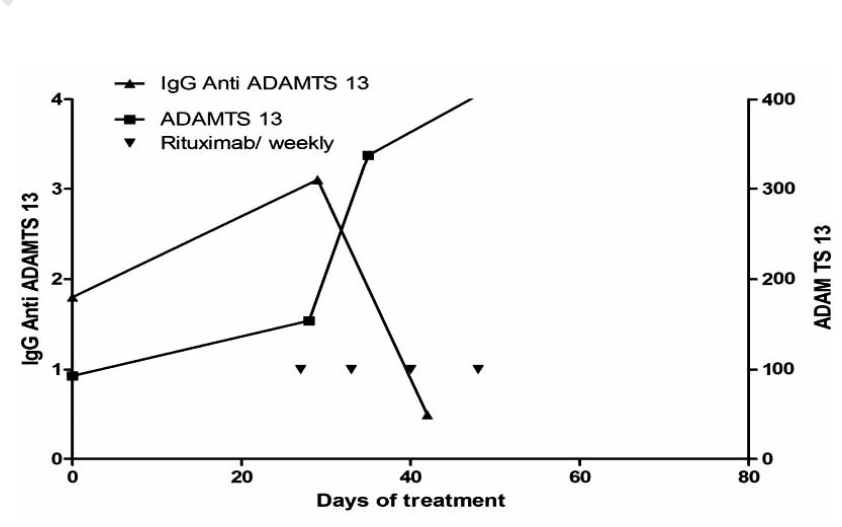
Figure 2. Time course of levels of ADAM TS 13 (ng/mL) and antibody to ADAM TS 13 (BEU) in relation to treatment with weekly